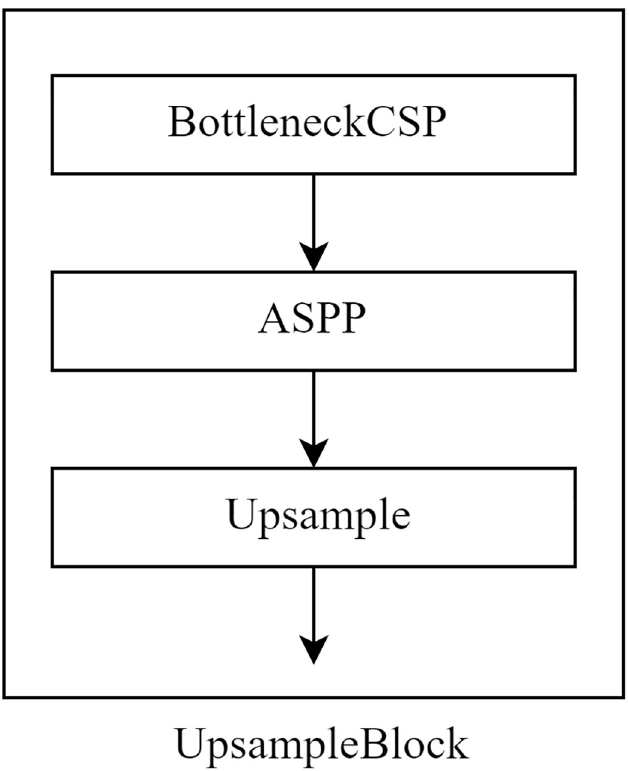
Fig 6. Structure of the vessel segmentation and diabetic retinopathy diagnostic cascade